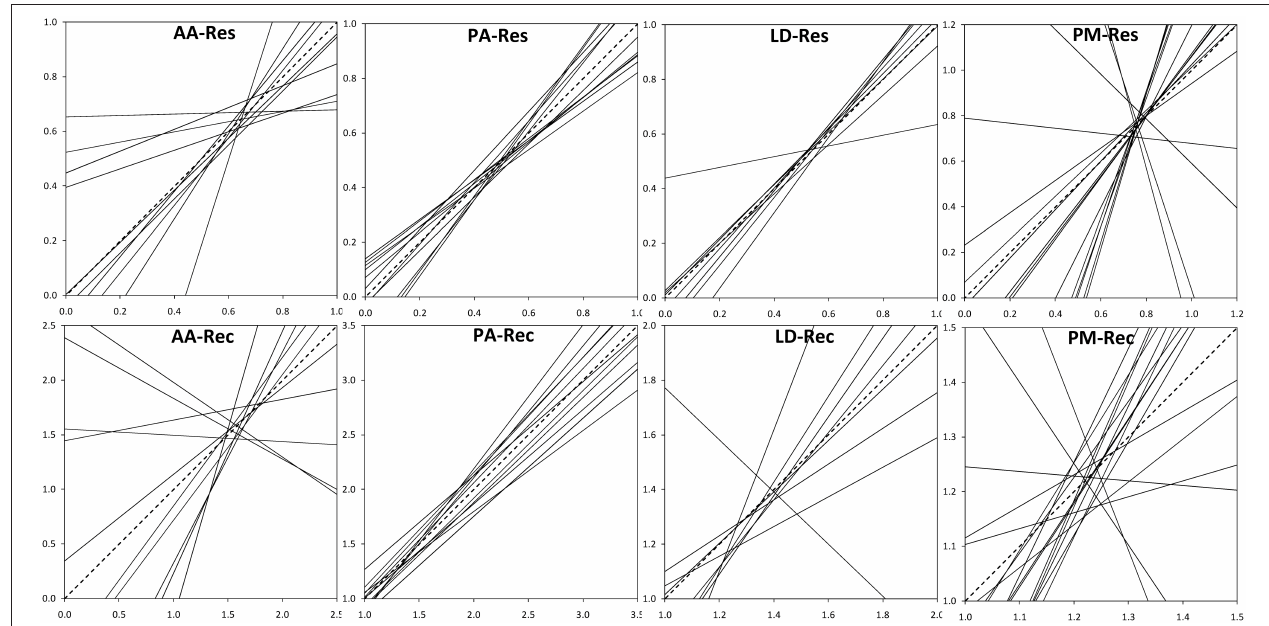
FIGURE 4 | Phenotypic stability of provenances throughout the three drought events according to Finlay and Wilkinson (1963). Dashed lines indicate the average stability. Provenances with high stability show slopes (regression coefficients) < 1, whereas slopes > 1 stand for instable provenances. Upper row: Resistance, Res; lower row: recovery, Rec. AA, Abies alba ; PA, Picea abies ; LD, Larix decidua ; PM, Pseudotsuga menziesii .